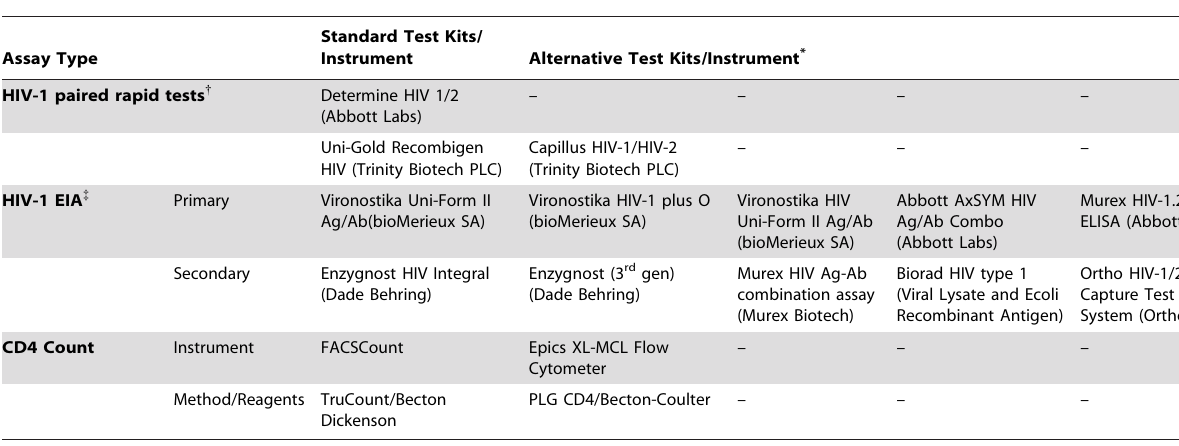
Table 1. HIV-1 and CD4 Diagnostic Assays Used for Study